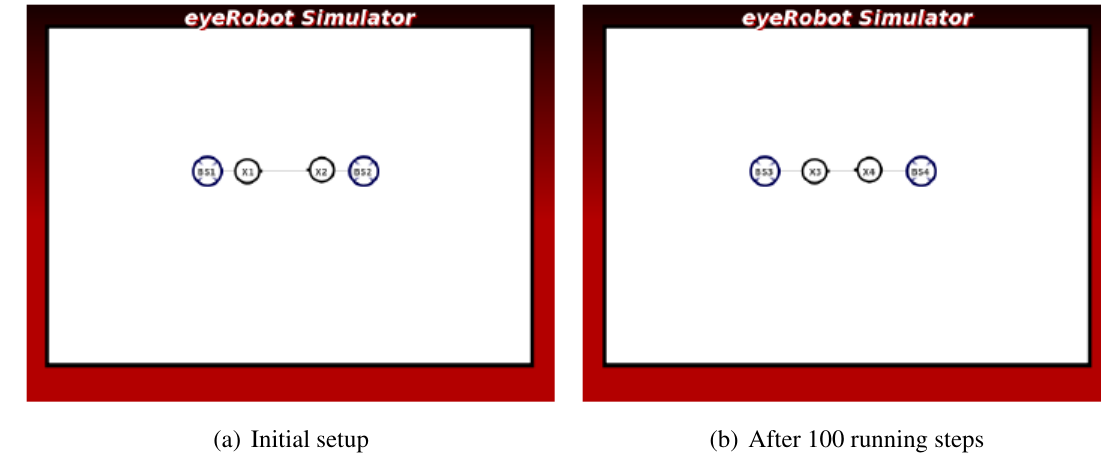
Figure 9. The experiment of Line scenario.